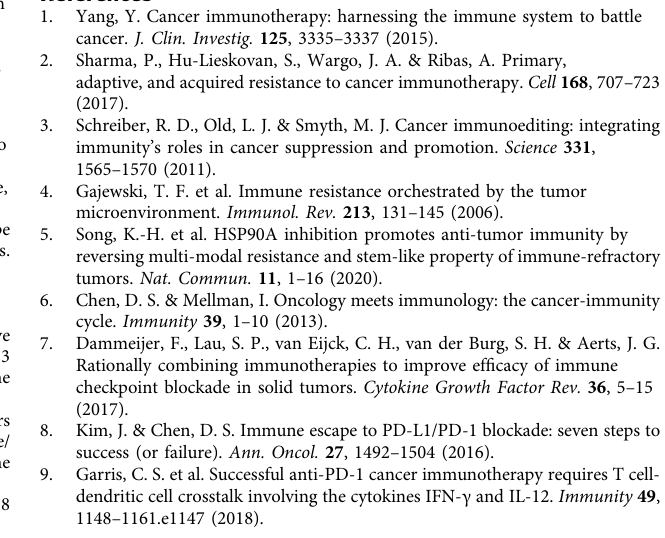
Fig. 7 TCTP inhibition by DHA renders the tumor susceptible to T cell-mediated therapy. a – f A375 P3 tumor-bearing NOD/SCID mice administered DHA with or without NY-ESO1-speci fi c T cell adoptive transfer treatment. b Tumor growth and c survival of mice inoculated with A375 P3 cells treated with the indicated reagents. d Flow cytometry pro fi les of CFSE + adoptively transferred NY-ESO1-speci fi c T cells. e The percentage of active-caspase-3